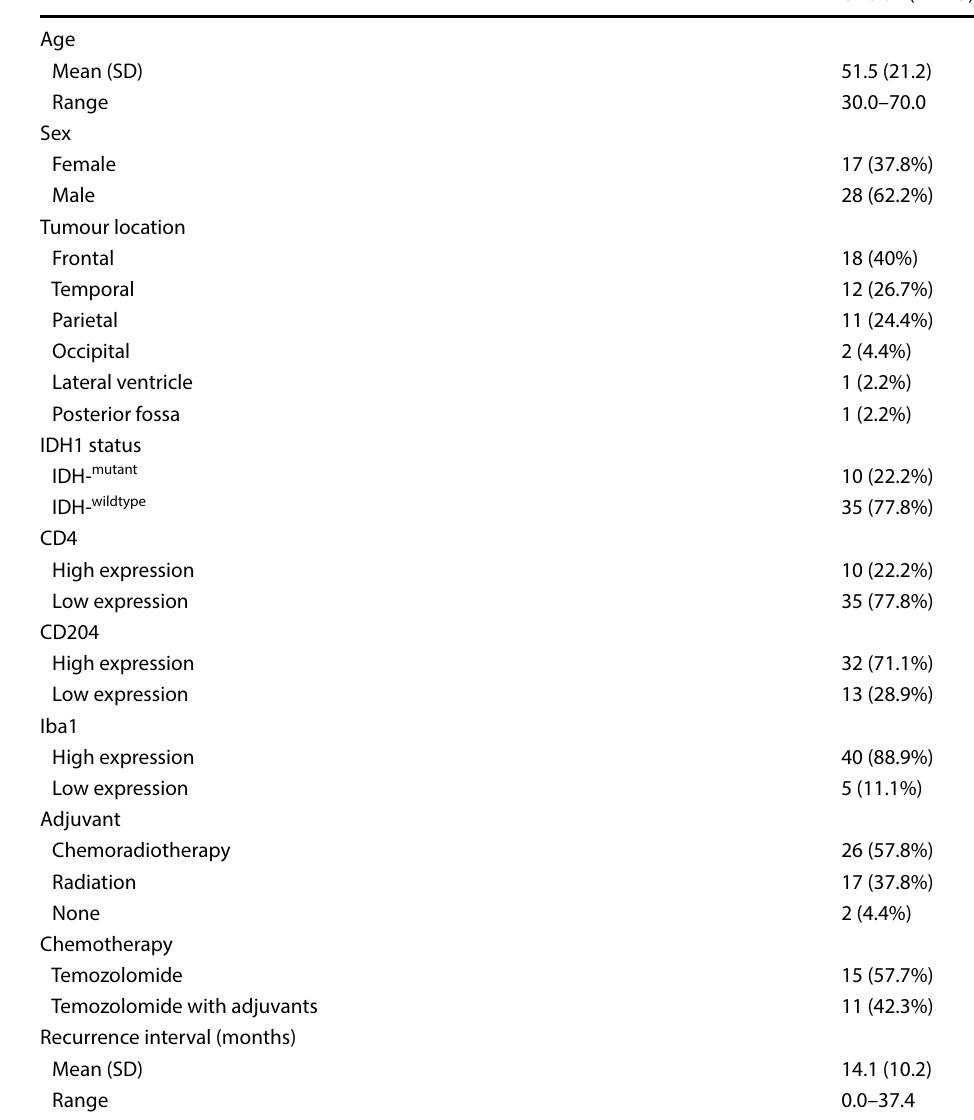
Table 3 Demographic data of the 45 glioblastoma patients enrolled in the study including clinical and biological